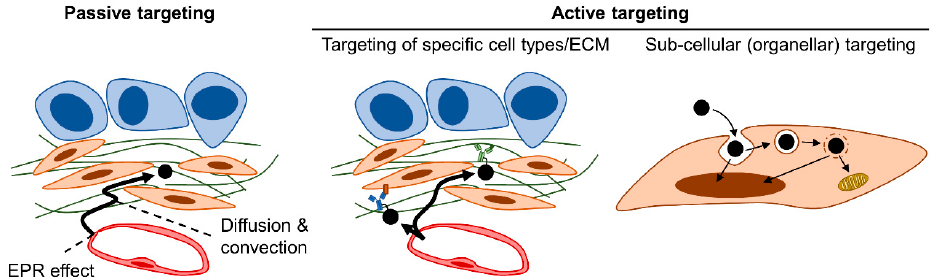
Figure 10. Passive vs. active targeting. Passive targeting of nanomedicine relies on extravasation via the enhanced permeability and retention (EPR) effect followed by diffusion and convection. In active targeting, moieties (antibody is depicted as an example in the figure) that recognize specific features of the tumor tissue (such as cell surface markers or ECM components) are utilized to enhance accumulation. Active targeting also encompasses sub-cellular (organellar) targeting, which is the targeted delivery of the payload to a specific organelle/location after internalization by the target cell.